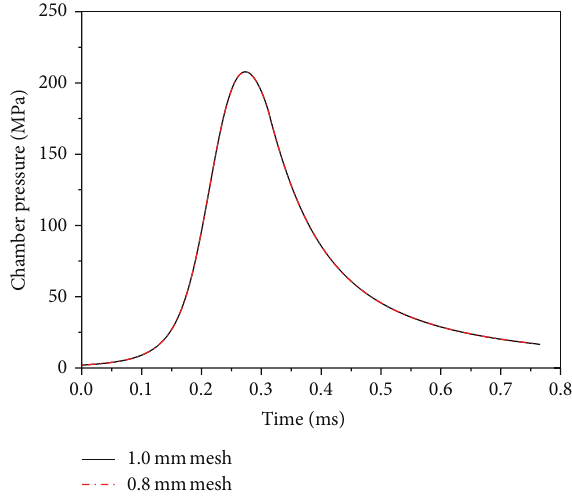
Figure 3: Chamber pressure-time history for 𝑚 𝑝 = 0.245 g, without barrel